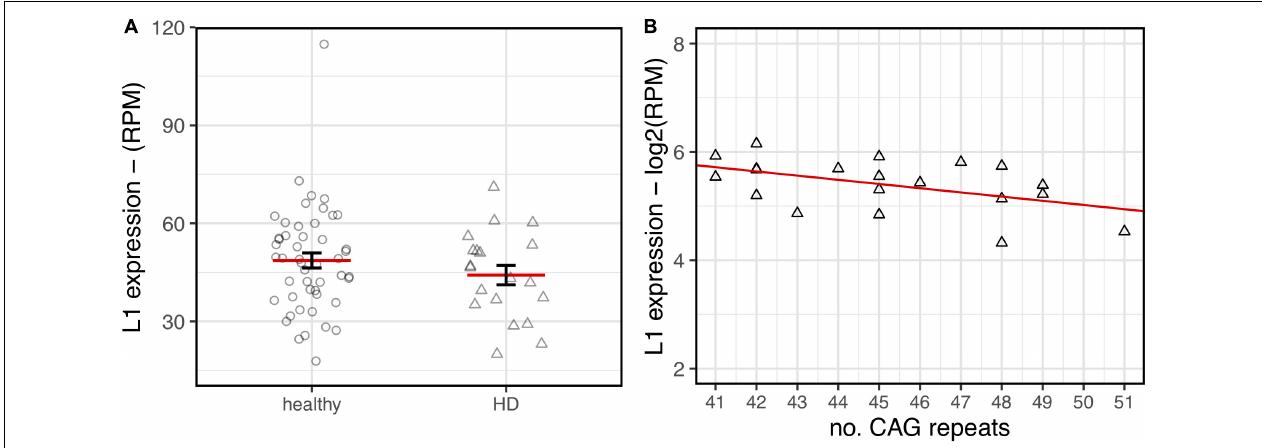
FIGURE 6 | L1HS expression in HD post-mortem human brains. RNA-seq data from healthy samples (circle, n = 49) and HD patients (triangle, n = 20) have been analyzed. (A) A decreasing trend of expression in HD brains is highlighted although lacking statistical significance ( p -value = 0.24). (B) Normalized L1 expression values ( y -axis) are associated to the number of CAG repeats ( x -axis) for human HD samples. The regression line shows a decreasing trend that reaches statistical significance ( R 2 = 0.24– p -value =